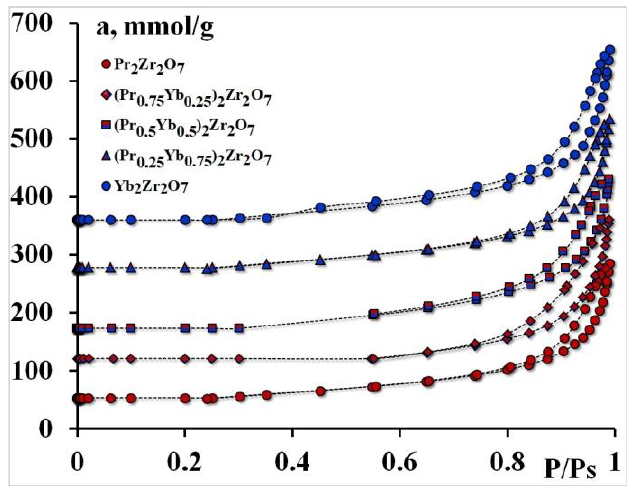
Figure 1. Adsorption isotherms.